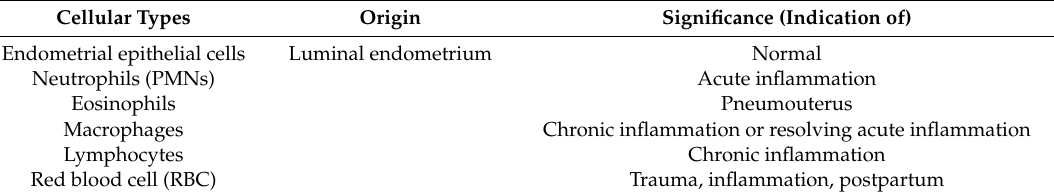
Table 1. Cellular types that may be encountered on cytological analysis, their origin and significance in jennies